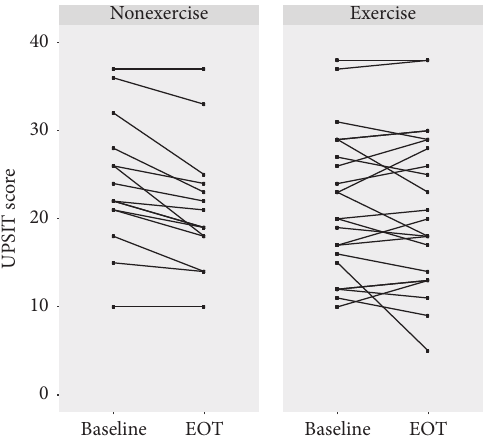
Figure 2: UPSIT scores at baseline and EOT for individuals in the exercise and nonexercise groups. At EOT, no participants in the nonexercise group demonstrated an improvement in UPSIT score; in contrast, 12 out of 23 individuals in the exercise group displayed an improvement in UPSIT score. Of note, 2 sets of individuals in the exercise group and 1 set of individuals in the nonexercise group scored identically from baseline to EOT; thus the lines are